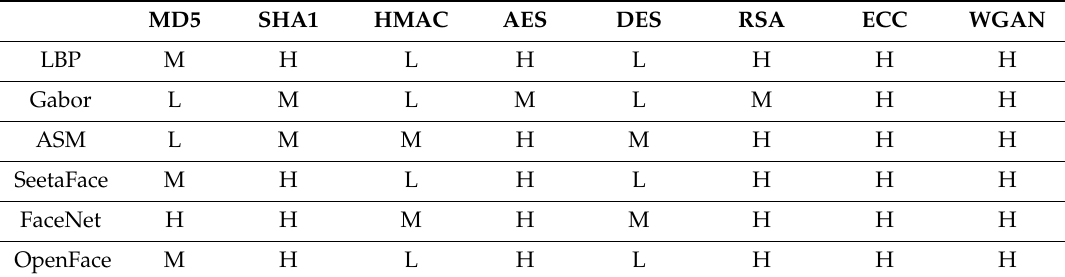
Table 1. Algorithm security analysis (L, Low; M, Medium; H, High).